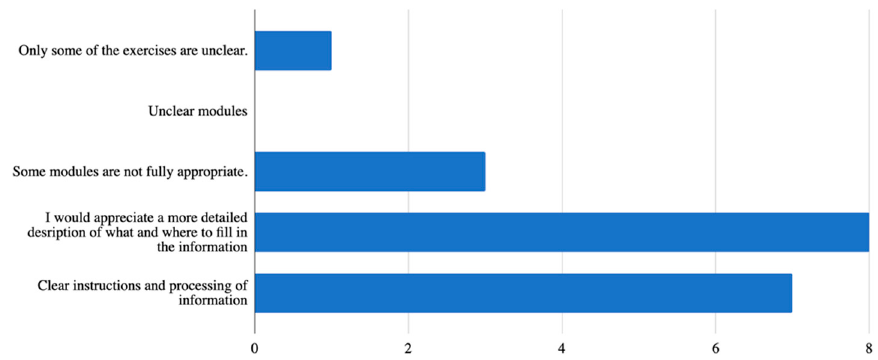
Figure 5. General opinion on the learning modules.